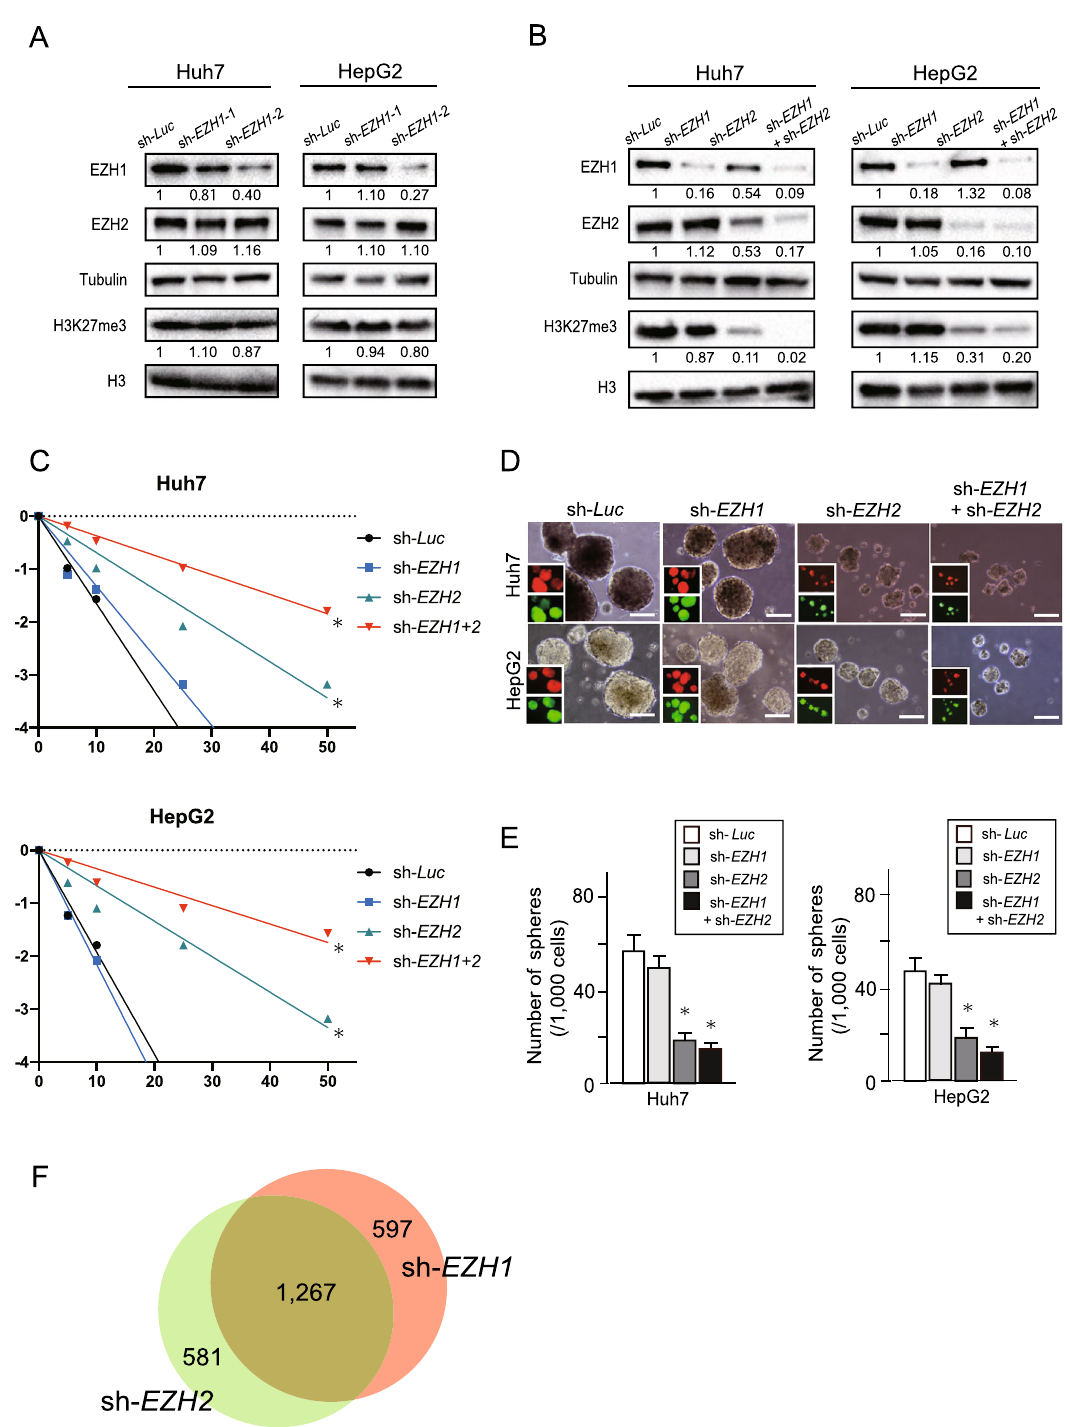
Figure 2. Knockdown of EZH1 and/or EZH2 in Huh7 and HepG2 cells. ( A ) Stable EZH1 knockdown cells were subjected to Western blot analyses. ( B ) Stable EZH1 and/or EZH2 -knockdown cells were subjected to Western blot analyses. ( C ) Limiting dilution assay of Huh7 and HepG2 cells transduced with sh- EZH1 , sh- EZH2 and sh- EZH1/2 . The sphere formation frequency was calculated by extreme limiting dilution analysis (* p < 0.05, ** p < 0.01). ( D ) Representative bright-field images of spheres formed on day 14 of low attachment cell culture. Fluorescence images are shown in insets. Scale bar = 100 µm. ( E ) Number of large spheres generated from 1000 cells transduced with the indicated viruses on culture day 14 (Student’s t test, * p < 0.05). ( F ) RNA sequence was performed using stable EZH1 or EZH2 -knockdown Huh7 cells. Venn diagram depicting the number of genes showing de-repression after EZH1 - or EZH2